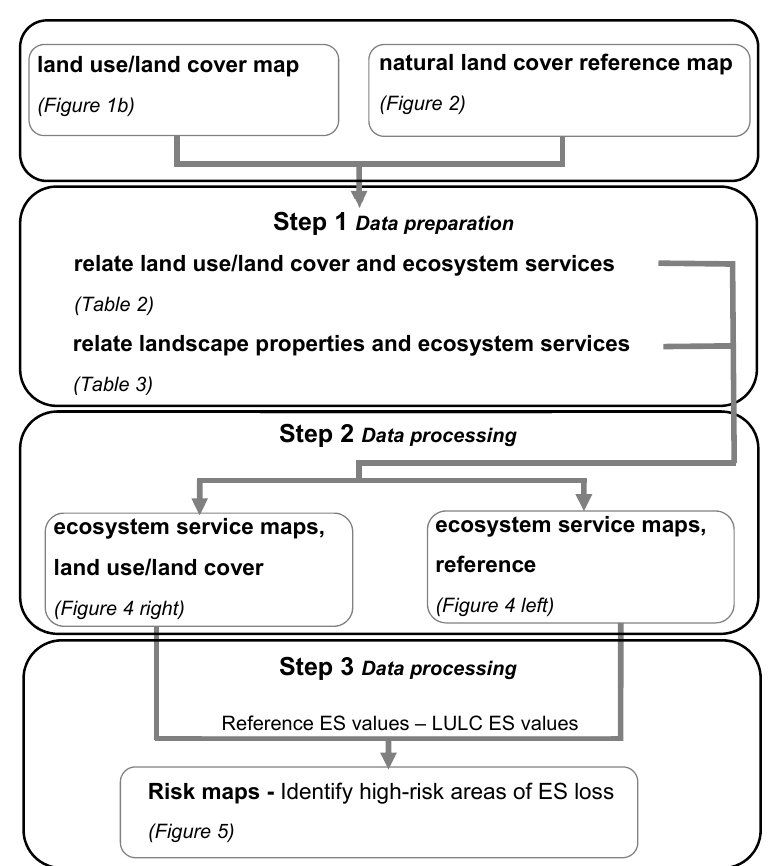
Figure 3. The three principal steps of the general workflow required to generate the ecosystem service and risk maps. (*ES: Ecosystem service). Figure created by authors.